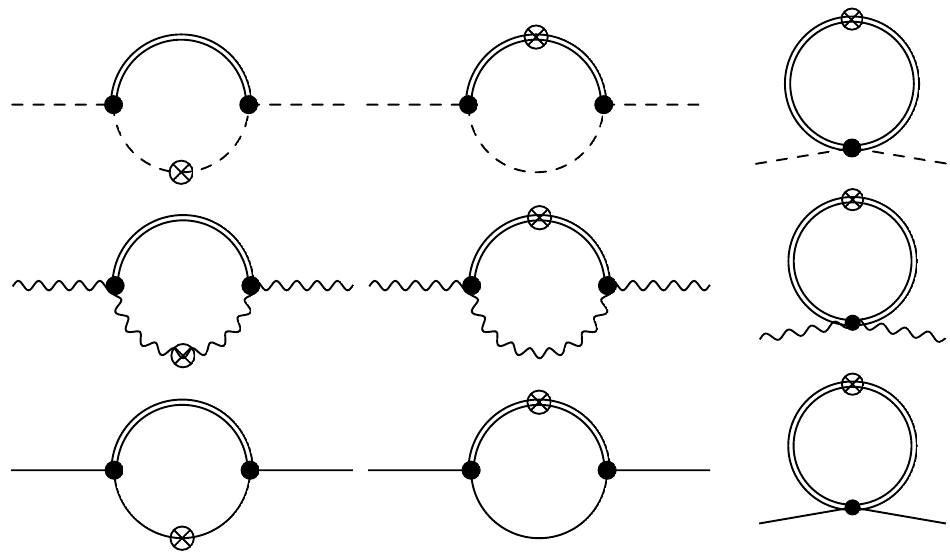
Figure 1 . Diagrams encoding the quantum-gravity contributions to the anomalous dimensions of the matter (cid:12)elds. Double lines correspond to the metric propagator, the dashed line represents a scalar (cid:12)eld, the wiggly line denotes a gauge (cid:12)eld and the single solid line stands for a fermionic (cid:12)eld. The crossed circle denotes the regulator insertion in eq.